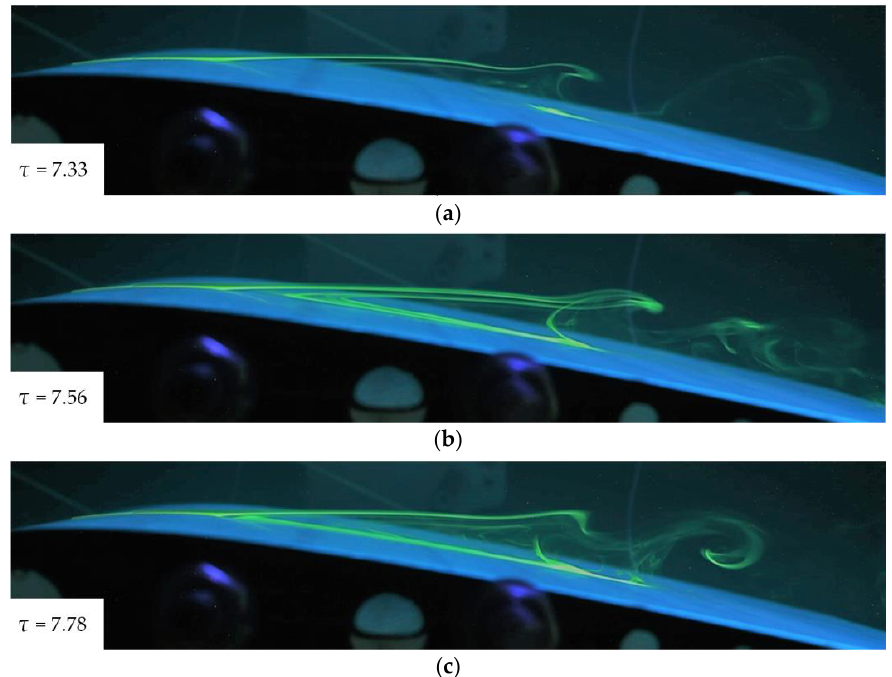
Figure 16. Flow images for standard Risø at Re = 2 × 10 4 , α = 9°: ( a ) τ = 7.33; ( b ) τ = 7.56; ( c ) τ = 7.78. Images of the flow around the airfoil with cavity A (sharp cavity) and Re = 2 × 10 4 are presented in Figures 17 and 18. For α = 6 ◦ the dye given from hole 2 flowed into the cavity. It did not flow through the top of the cavity, it headed to the front wall of the cavity. Here, it split, creating two dye threads. One of them flowed up, the second one flowed down. The part of the dye that flowed to the bottom of the cavity gives the outline of a structure that rotates opposite to the streamwise direction. It is difficult to judge the direction of rotation. On the surface of the airfoil behind the cavity, strong dye dissipation was